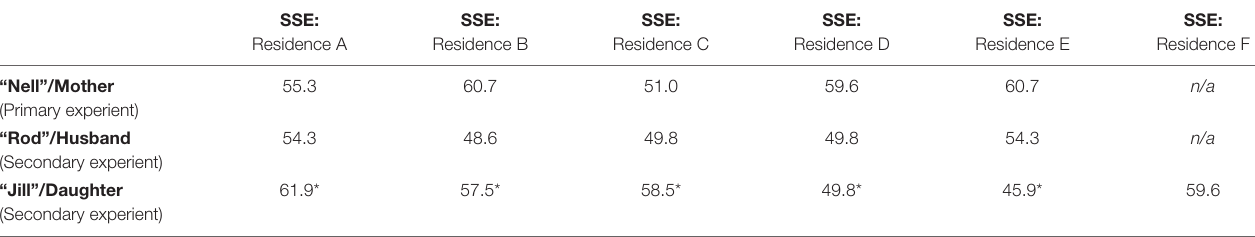
TABLE 5 | Family members’ SSE scores (“Haunt Intensity”) across the successive residences.